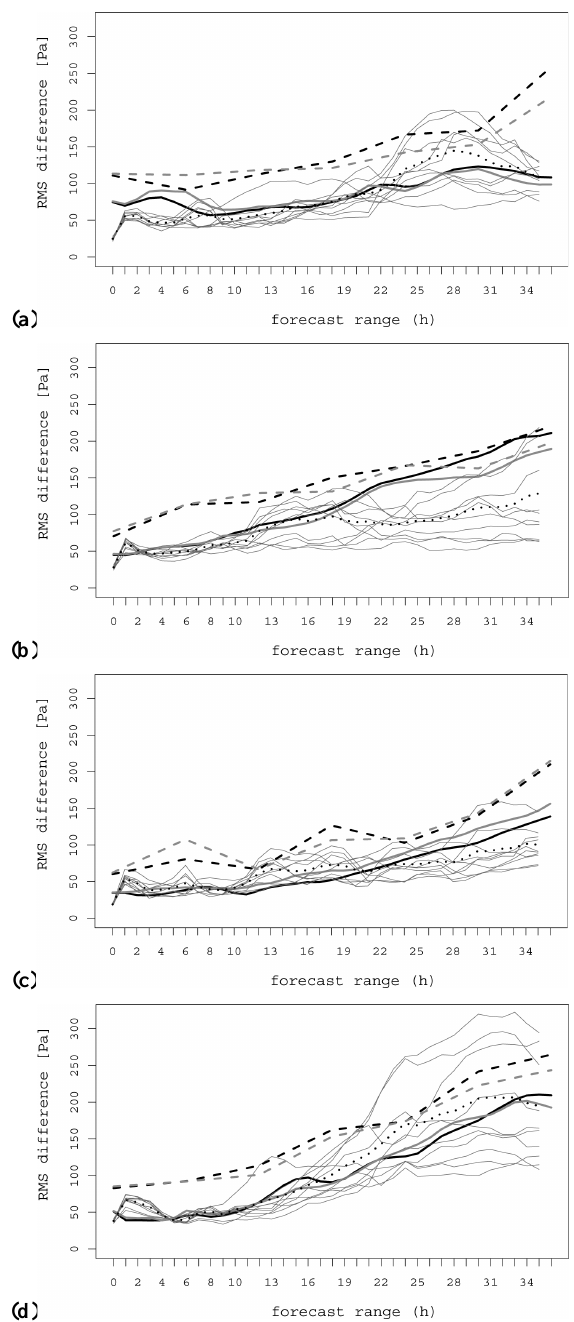
Fig. 4. The same as in Fig. 3 but for mean sea level